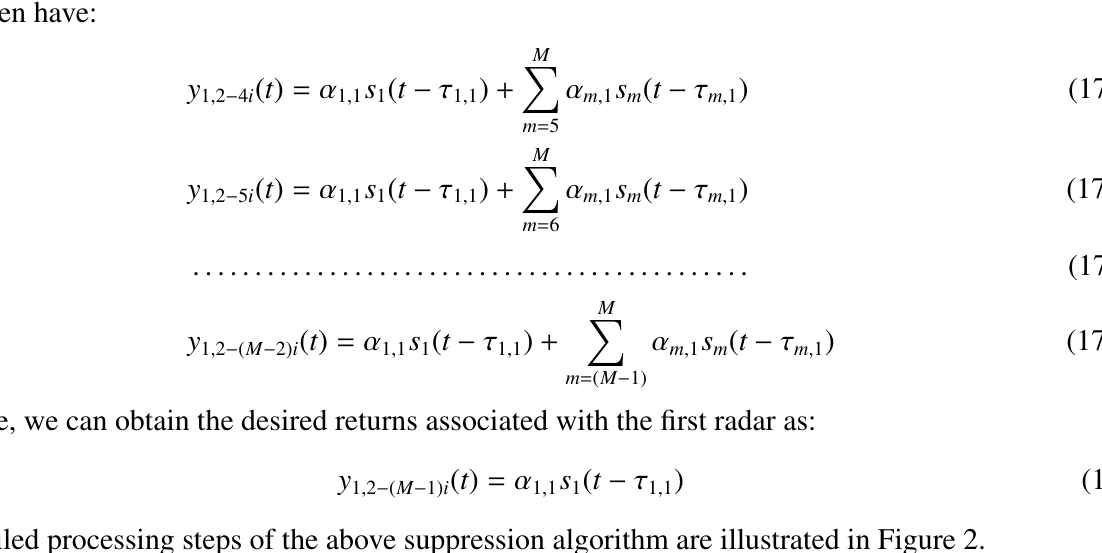
Figure 2. Block diagram of the interference suppression algorithm. mixed multiple radar returns w e w ant to extract the first radar's returns h cross-matched filtering w ith reference function ( ) t m filtered by in time domain Fourier transforming filtered by in frequency domain inverse Fourier transforming No m=M ?